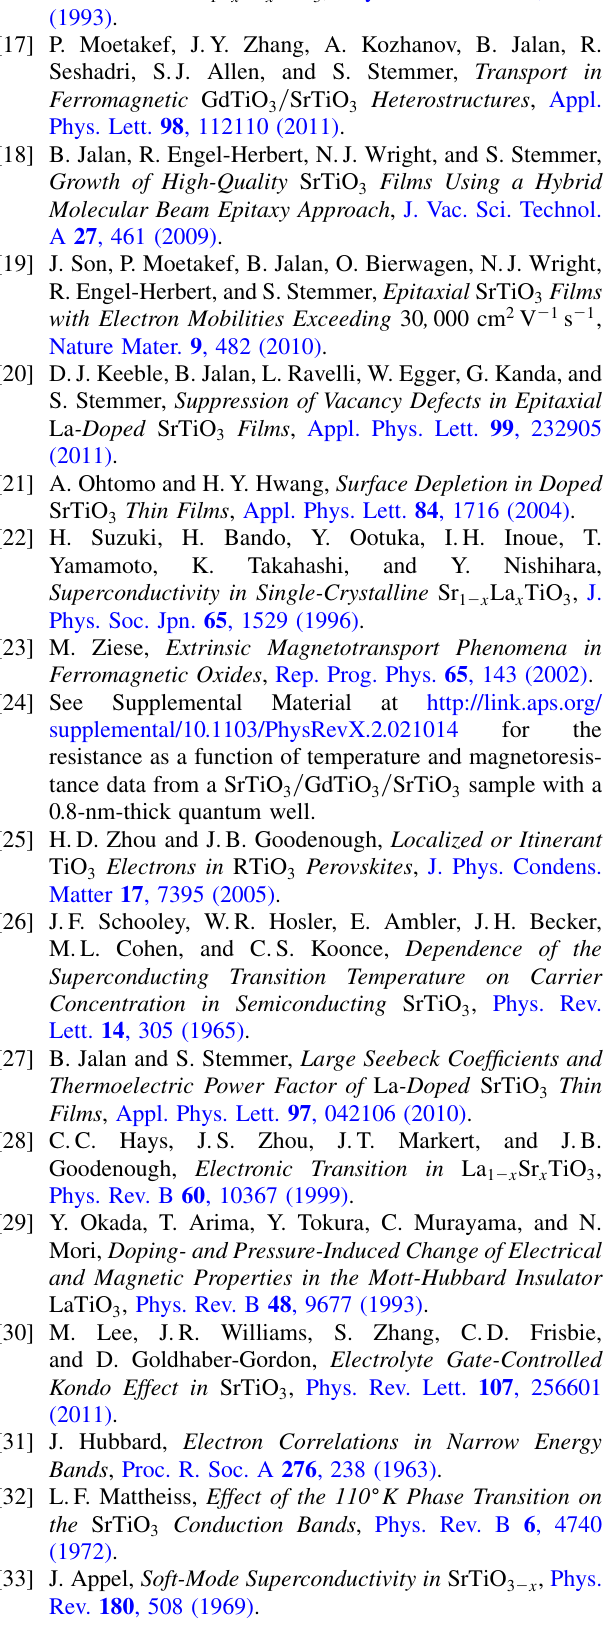
Supplemental Material at http://link.aps.org/ supplemental/10.1103/PhysRevX.2.021014 for the resistance as a function of temperature and magnetoresis- tance data from a SrTiO 3 = GdTiO 3 = SrTiO 3 sample with a 0.8-nm-thick quantum